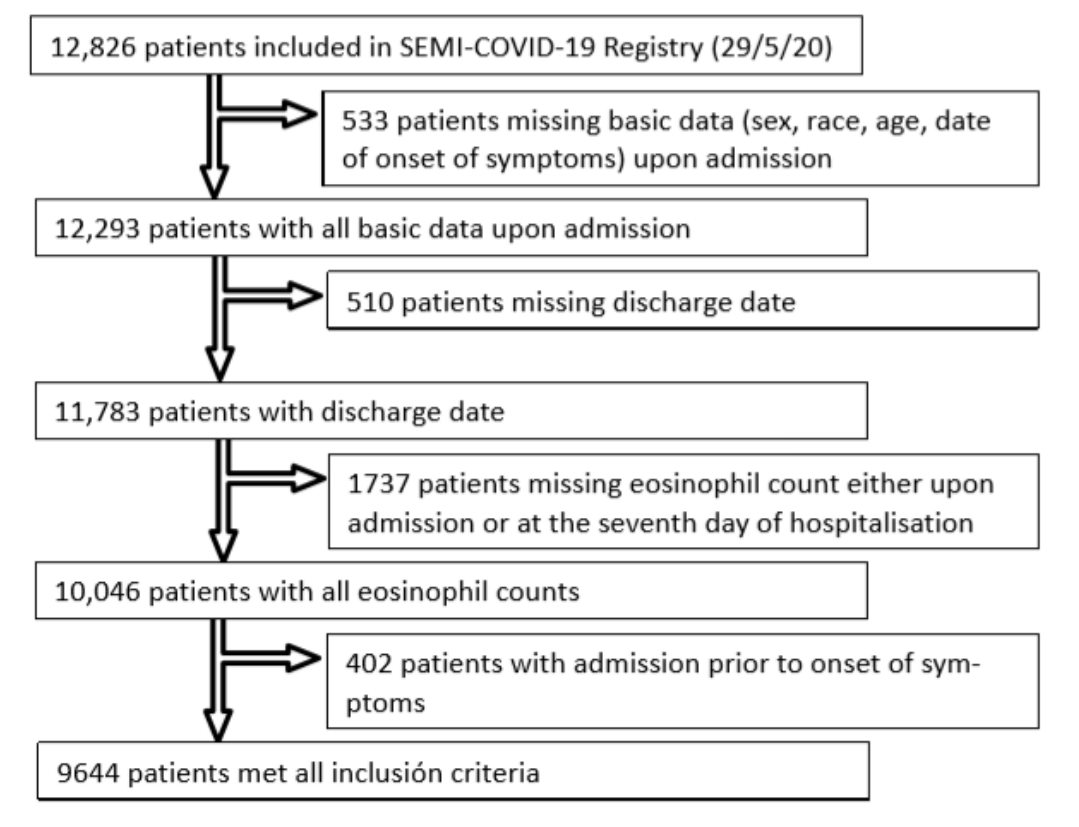
Figure 1. Patient Flowchart.